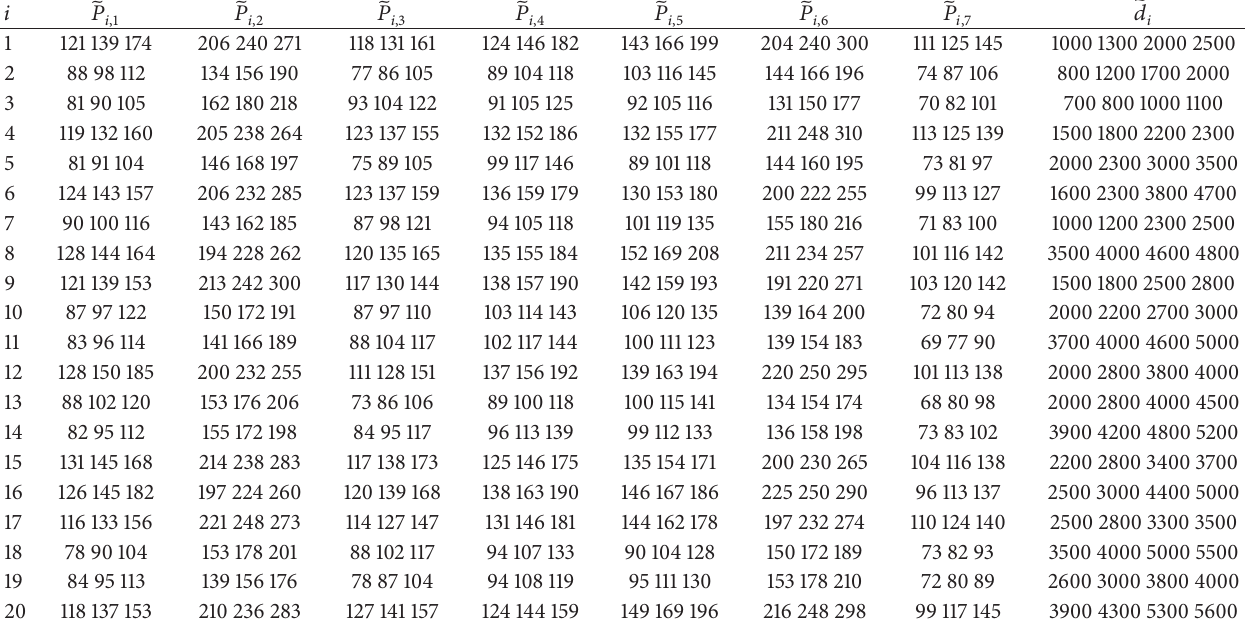
Table 10: Fuzzy processing time and fuzzy due date of the 20 × 7 fuzzy FSSP.